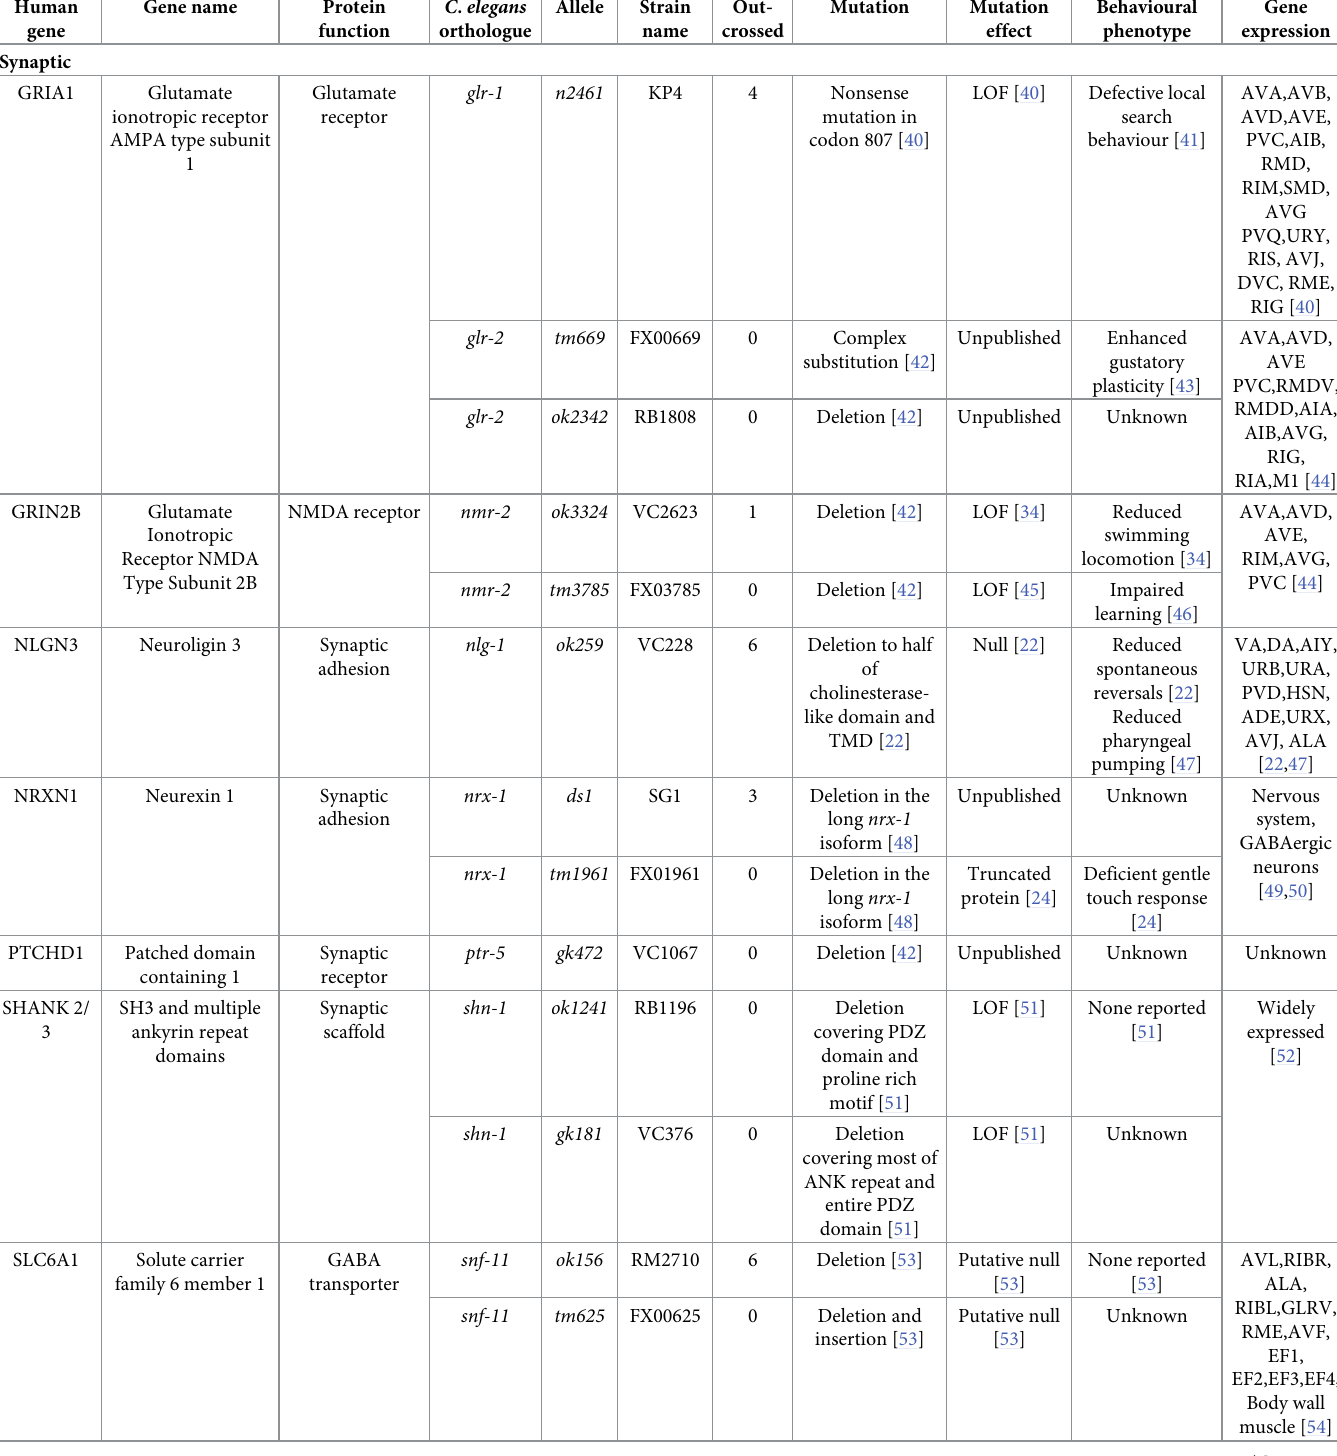
Table 1. Summary of human genes prioritised for study in C . elegans mutant